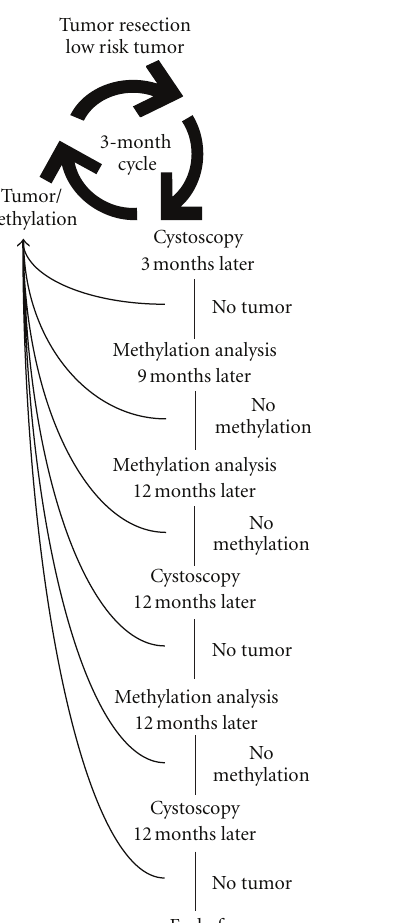
Figure 1: Follow-up model for low- and medium-risk NMIBC in which methylation markers were applied to prolong time between